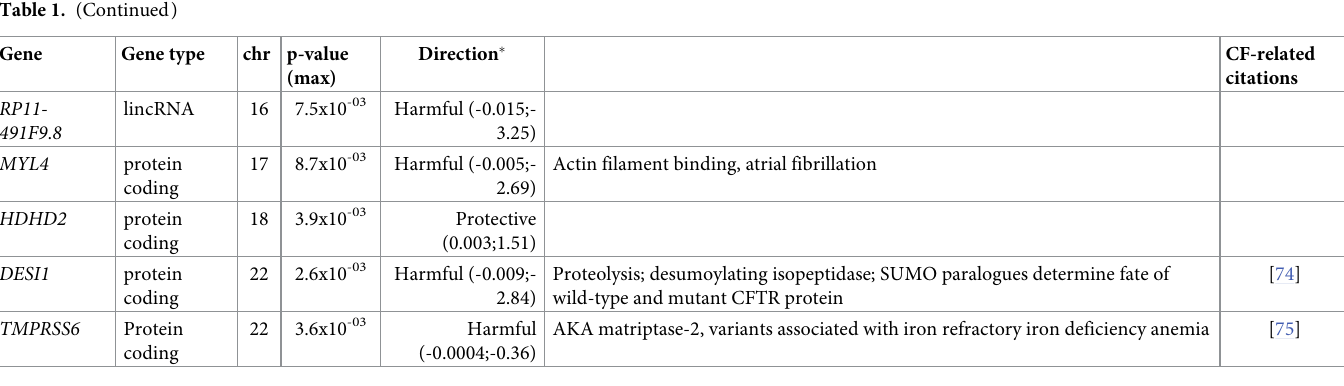
categories identified with CF relevance (Table 1), we classified 149 of the 379 candidate genes into 11 functional categories (Table 2).